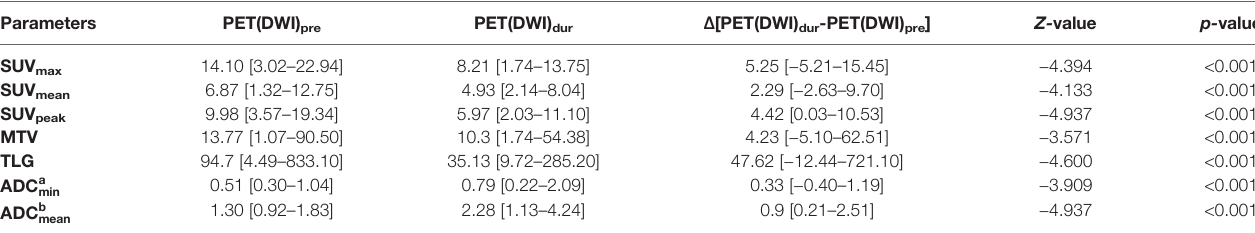
TABLE 2 | Comparison of tumor ADC and SUV values before and during radiotherapy.